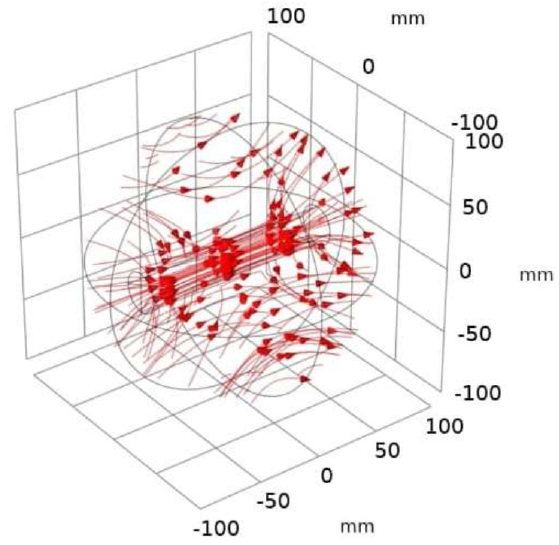
Figure 7. Current density in the proximity of conductive fibers.